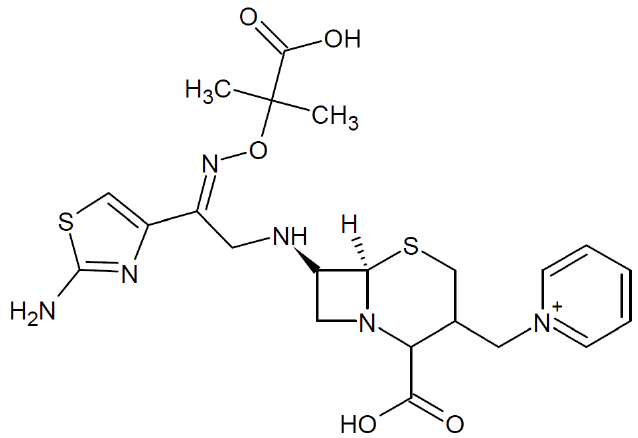
Figure 1. CZ chemical structure.